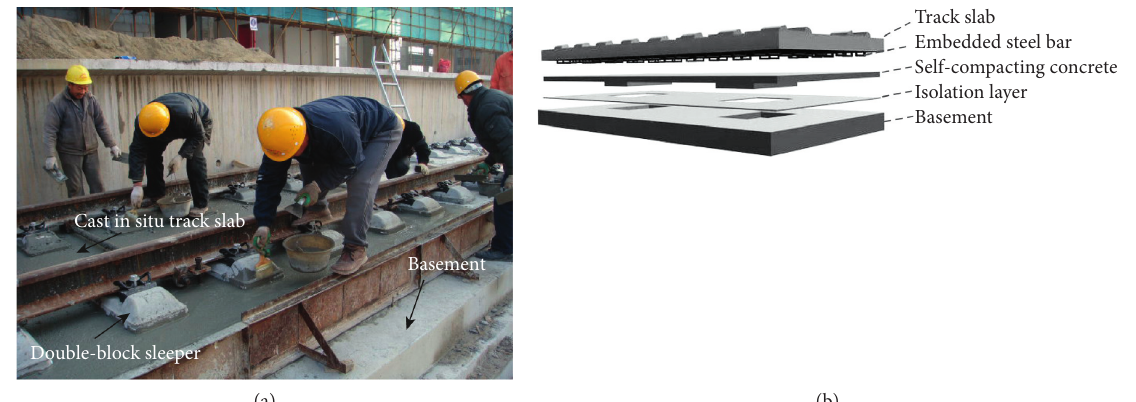
Figure 2: The unit-plate-type unballasted tracks. (a) Double-block-type unballasted track. (b) CRTS III-type unballasted track.